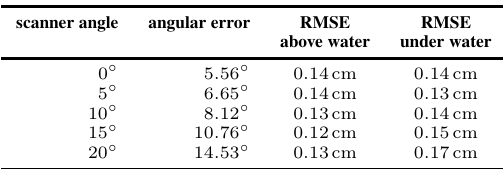
Table 1. Angular errors between the plane normals above and below water for the initial uncorrected reconstruction result. Root mean square error (RMSE) of the plane fit.